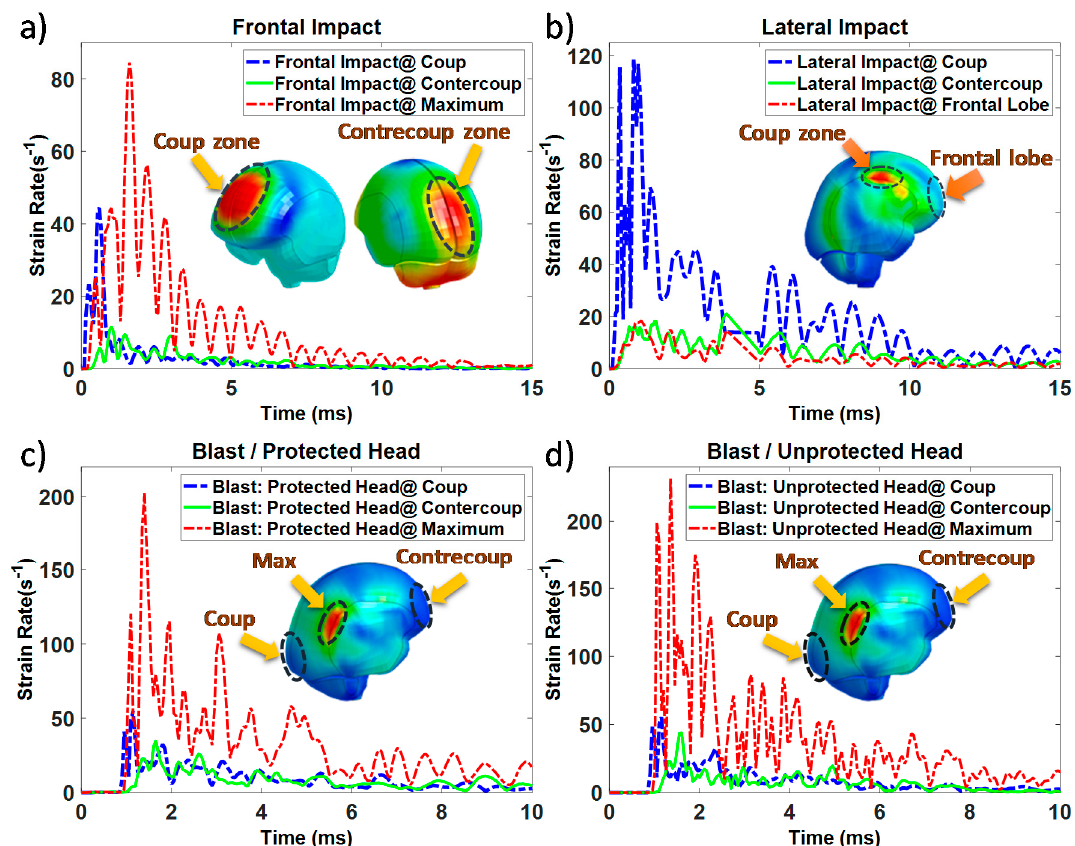
Figure 6. Histories of strain rate at three different regions of the brain under: ( a ) frontal and ( b ) lateral impact by golf ball, and heavy blast scenarios for ( c ) protected and ( d ) unprotected head.